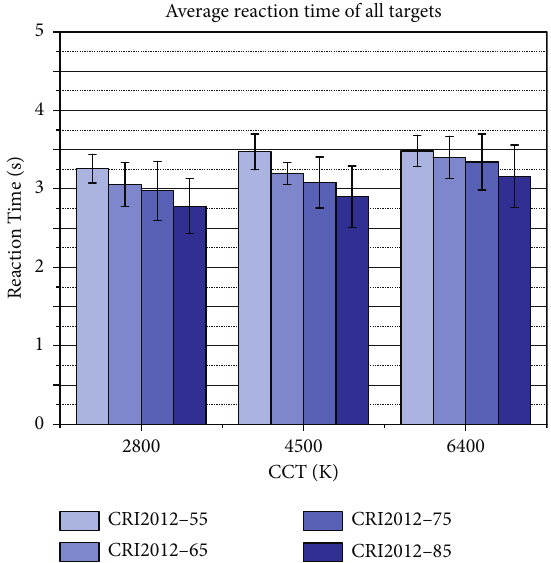
Figure 13: All colour’s average reaction time under 12 lighting conditions.